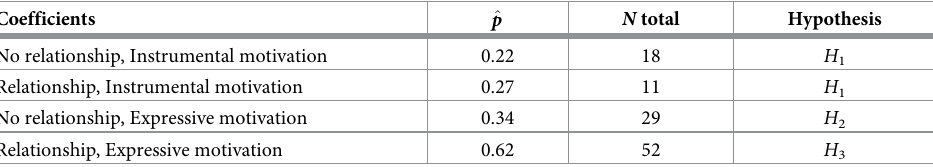
Table 3. Proportion of cases of indirect cyber abuse for various combinations of variables.